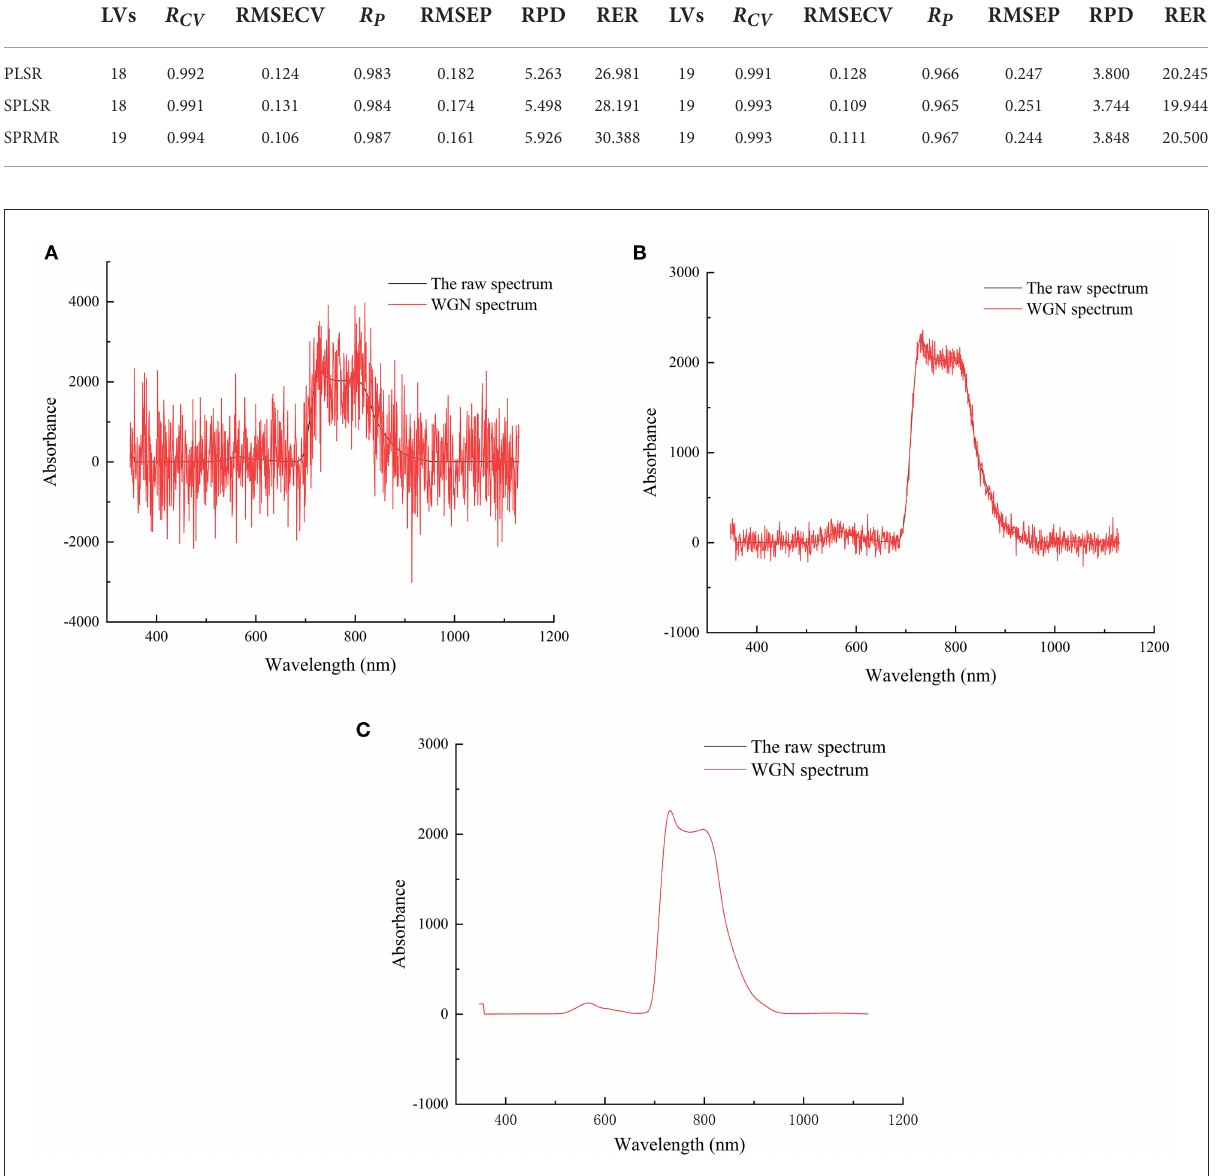
was added to observe the recognition accuracy of the PLSR, SPLSR and SPRMR models on noise and abnormal samples. In the experiment, the intensity of the added WGN is adjusted by changing the signal-to-noise ratio (SNR). N is set as 10, i.e., 10 samples are randomly drawn from both datasets and added with noise. Figure 4 shows three spectra with SNR of − 10, 10, 50 in static detection mode.